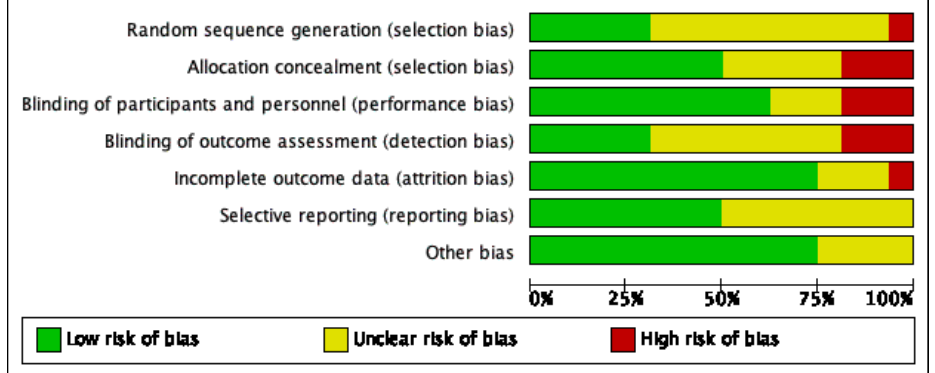
Figure 2. Risk of bias summary.